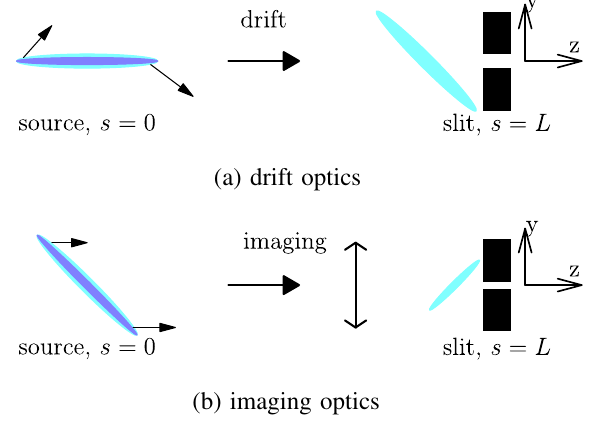
FIG. 2. Illustration of two photon beam optics between source points and pulse selection slits. (a) y 0 - z tilt at the source point becomes y - z tilt at the short pulse selection slit; (b) the photon beam with a y - z slope at the source point is imaged to the